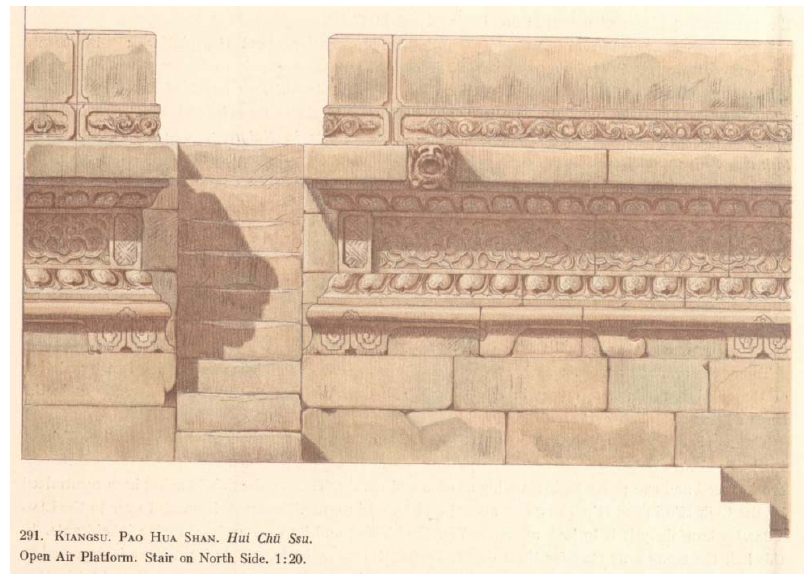
Figure 15. Rendering of the Open ‐ Air Platform (Prip ‐ Møller 1937, p. 236, Figure 291).